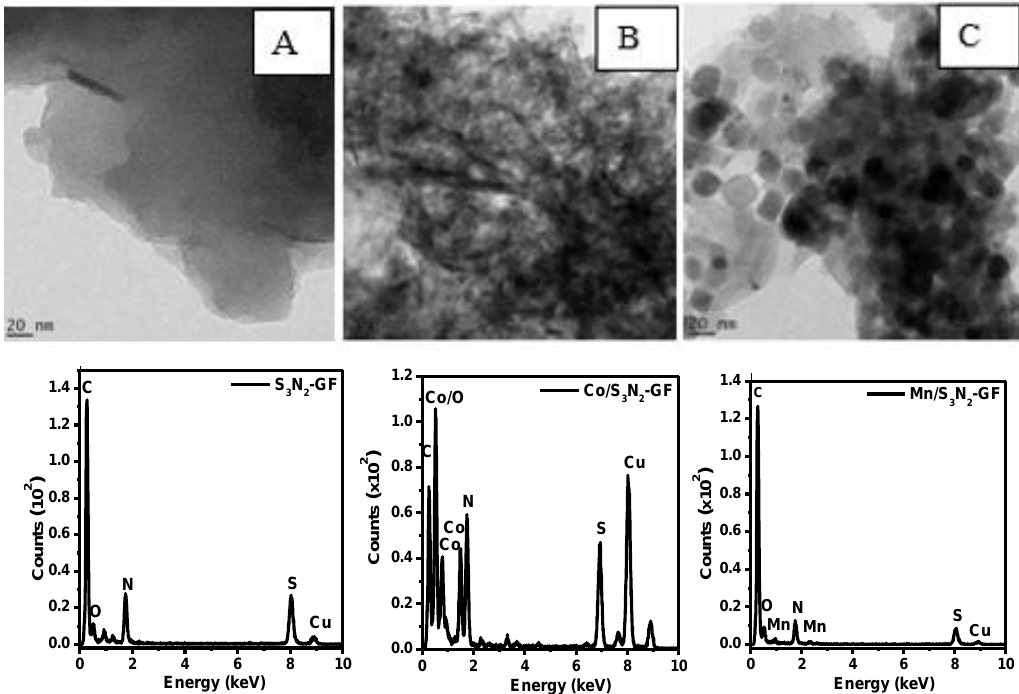
Figure 4. Transmission electron micrographs of S 3 N 2 –GF ( A ), Co / S 3 N 2 –GF ( B ) and Mn / S 3 N 2 –GF ( C ) with their corresponding EDS spectra.